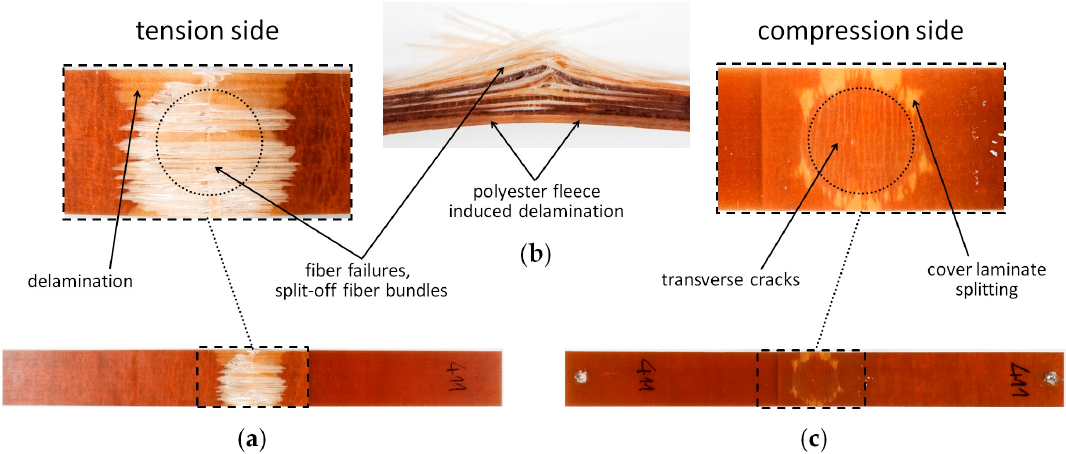
Figure 11. Surface photographs of an exemplary ruptured LATP–GFRP four-point bending specimen, tension side view ( a ), side view ( b ), and compression side view ( c ).